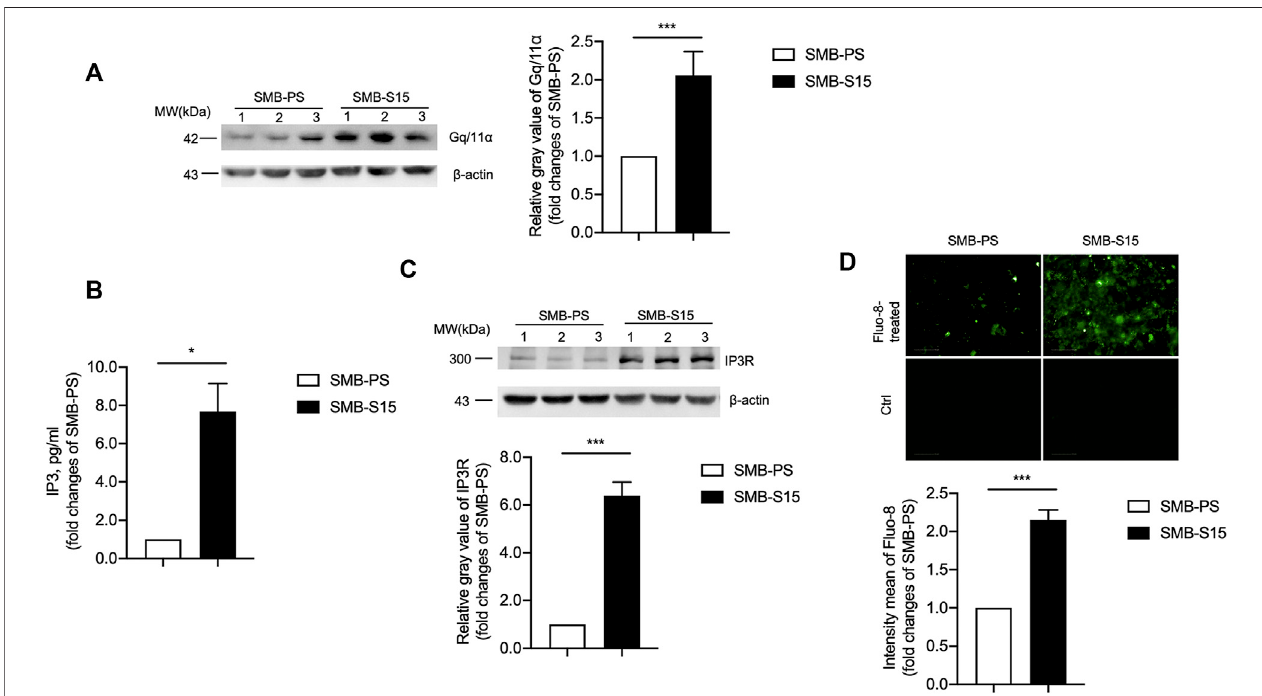
FIGURE 3| Activation ofthe GPCRs-IP3-IP3R-Ca 2+ pathway in twoSMB cell lines. (A) Left: Western blots for the levels ofGq/11 α . Relative molecular weights are marked on the left. Two SMB cell lines are indicated above. (1, 2, 3) indicate the number of replicates. Right: Densitometric analyses of the average gray values of the signals of the Gq/11 α after being equilibrated with that of β -actin. (B) ELISA for the levels of IP3. (C) Top: Western blots for the levels of IP3R. Relative molecular weights are marked on the left. Two SMB cell lines are indicated above. Bottom: Densitometric analyses of the average gray values of the signals of the IP3R after being equilibratedwiththatof β -actin. (D) Top: ImmunocytochemicalassaysforthelevelsofCa 2+ concentration. Bottom: TheIODanalysisforthesignalsofCa 2+ intheimages of two SMB cell lines. The quantitative results are presented as mean + SEM.